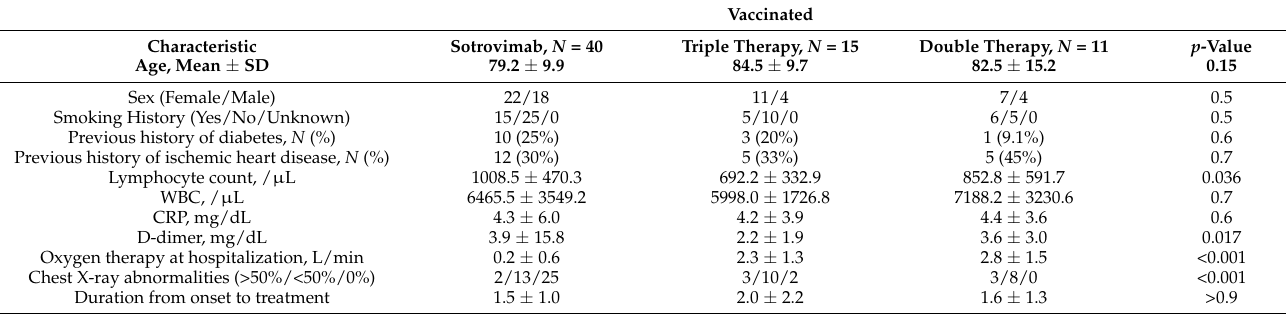
Table 3. Patient characteristics during the BA.5